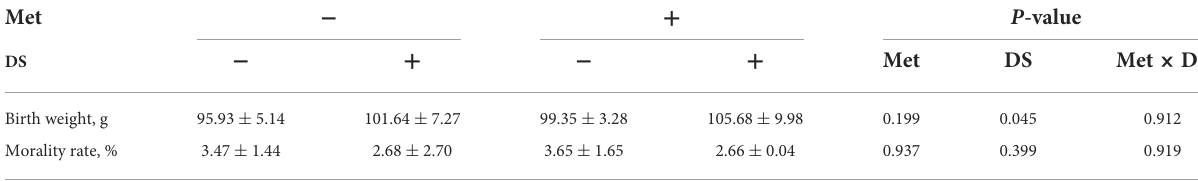
TABLE 3 Effects of in ovo injection of methionine (Met) and disaccharide (DS) on growth performance parameters of geese during the early-life post-hatching a,b . Met